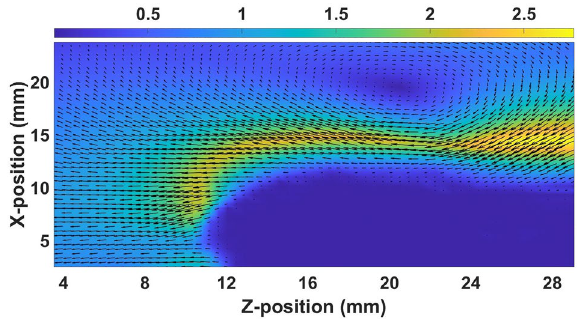
Figure 5. The velocity vector field with the magnitude of the velocity (cm/s) for the single layer flow at the input pressure of the pulse valve is 300 Pa.